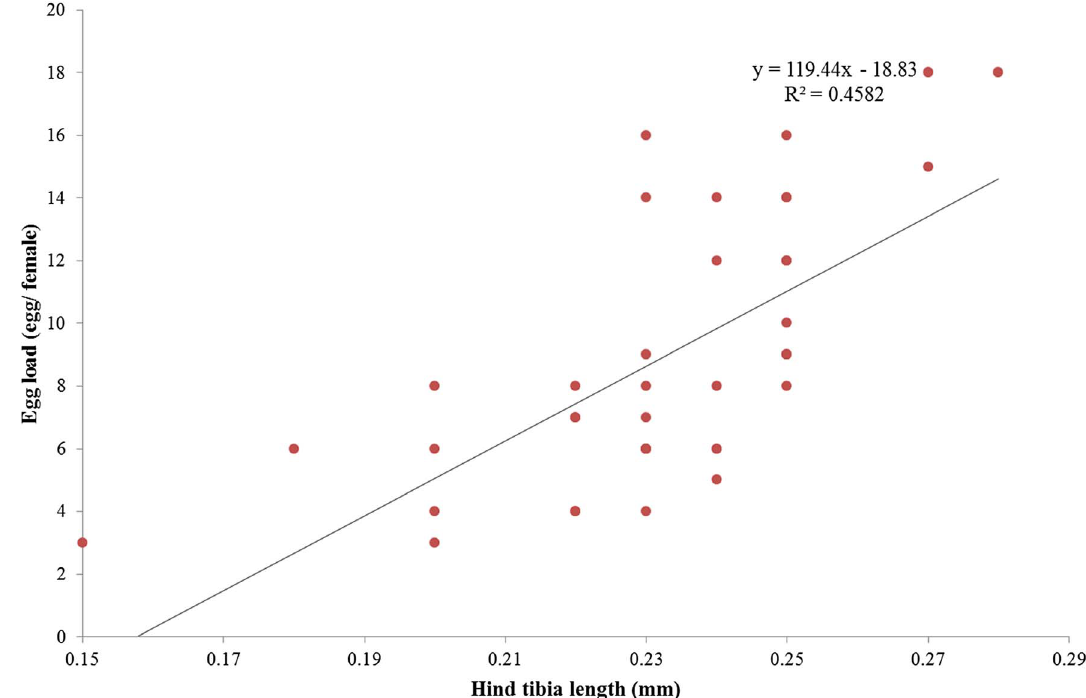
Figure 4. Relationship between predicted egg load ( y ) and size ( x ) of Quadrastichus mendeli ( n = 40, p <